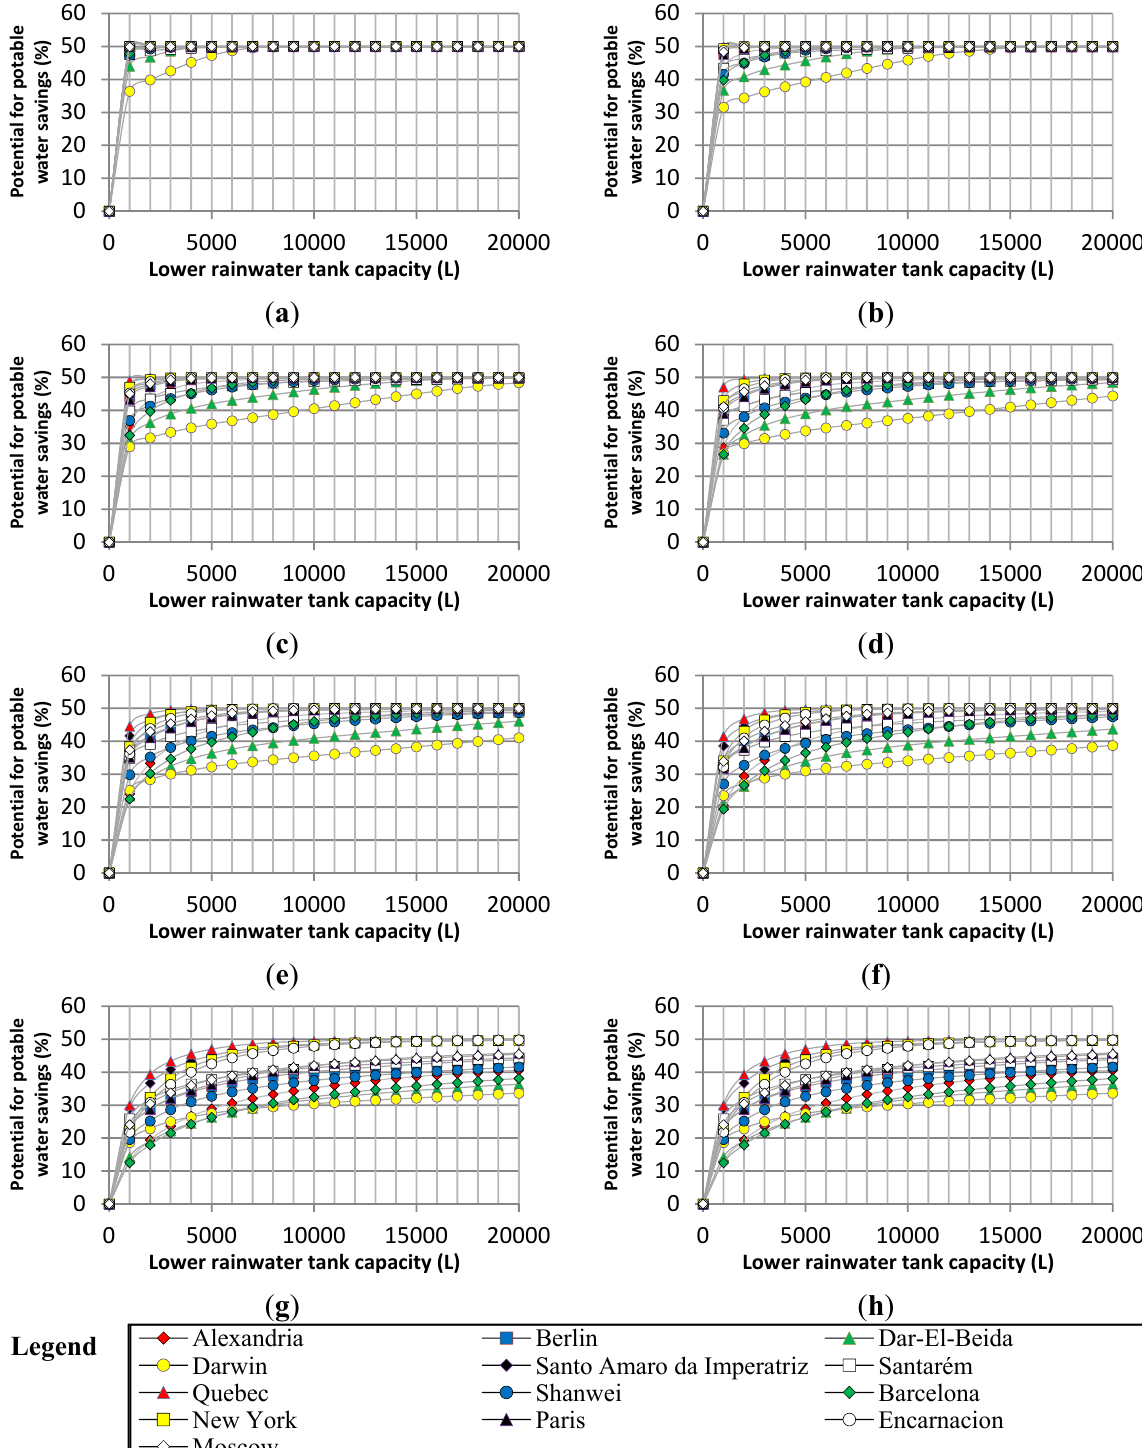
Figure 7. Potential for potable water savings for each city as a function of rainwater demand and catchment surface area of 400 m 2 . ( a ) Rainwater demand of 50 L per house per day; ( b ) Rainwater demand of 100 L per house per day; ( c ) Rainwater demand of 150 L per house per day; ( d ) Rainwater demand of 200 L per house per day; ( e ) Rainwater demand of 250 L per house per day; ( f ) Rainwater demand of 300 L per house per day; ( g ) Rainwater demand of 400 L per house per day; ( h ) Rainwater demand of 500 L per house per